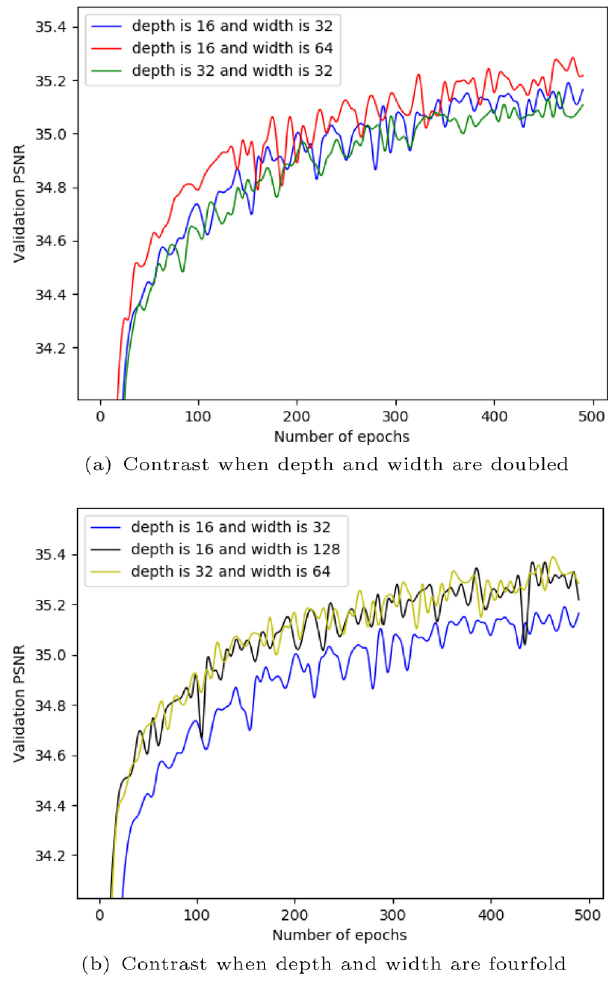
Fig. 5 Effects of increasing depth and increasing width on the